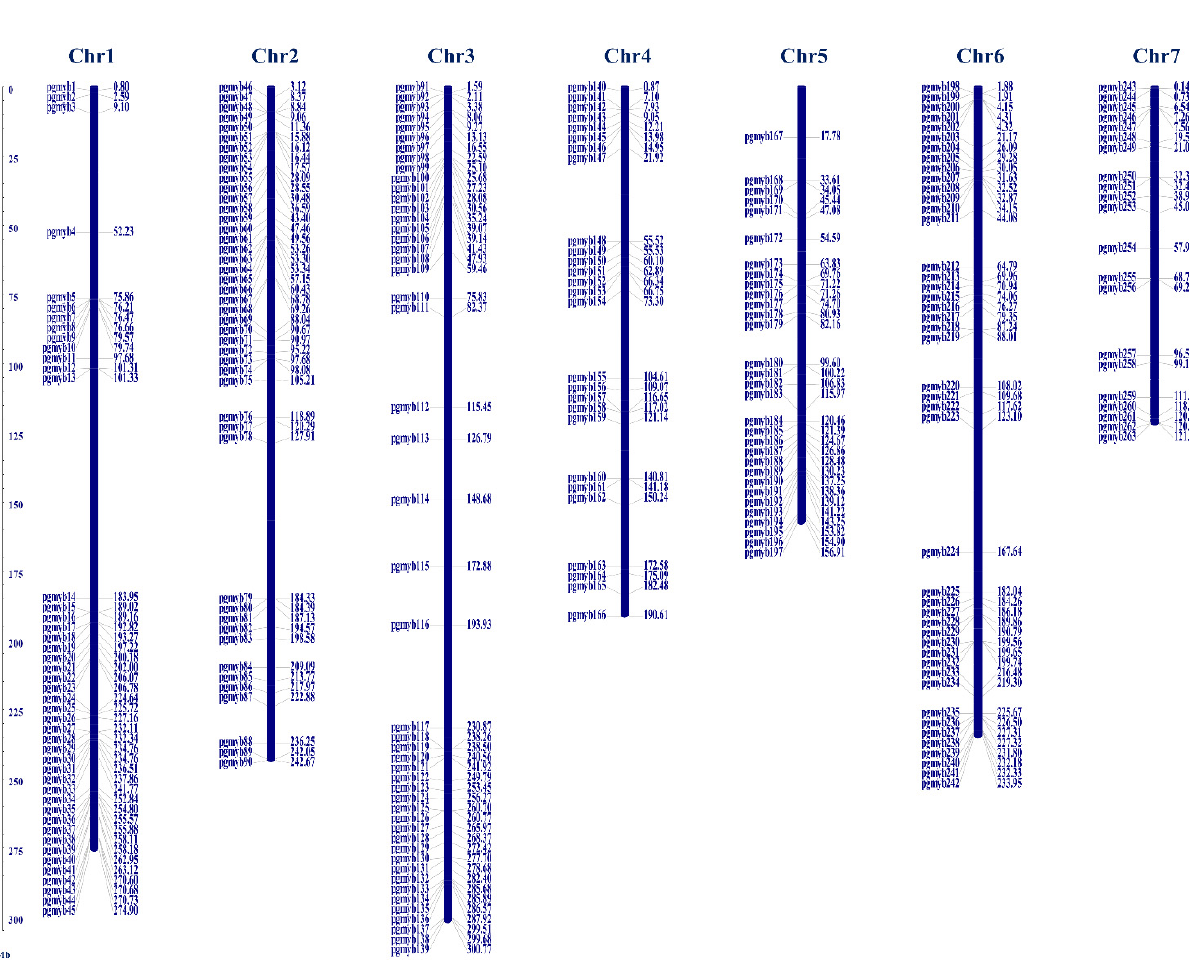
Figure 1. Chromosomal mapping of identified 279 PgMYB members on pearl millet genome.